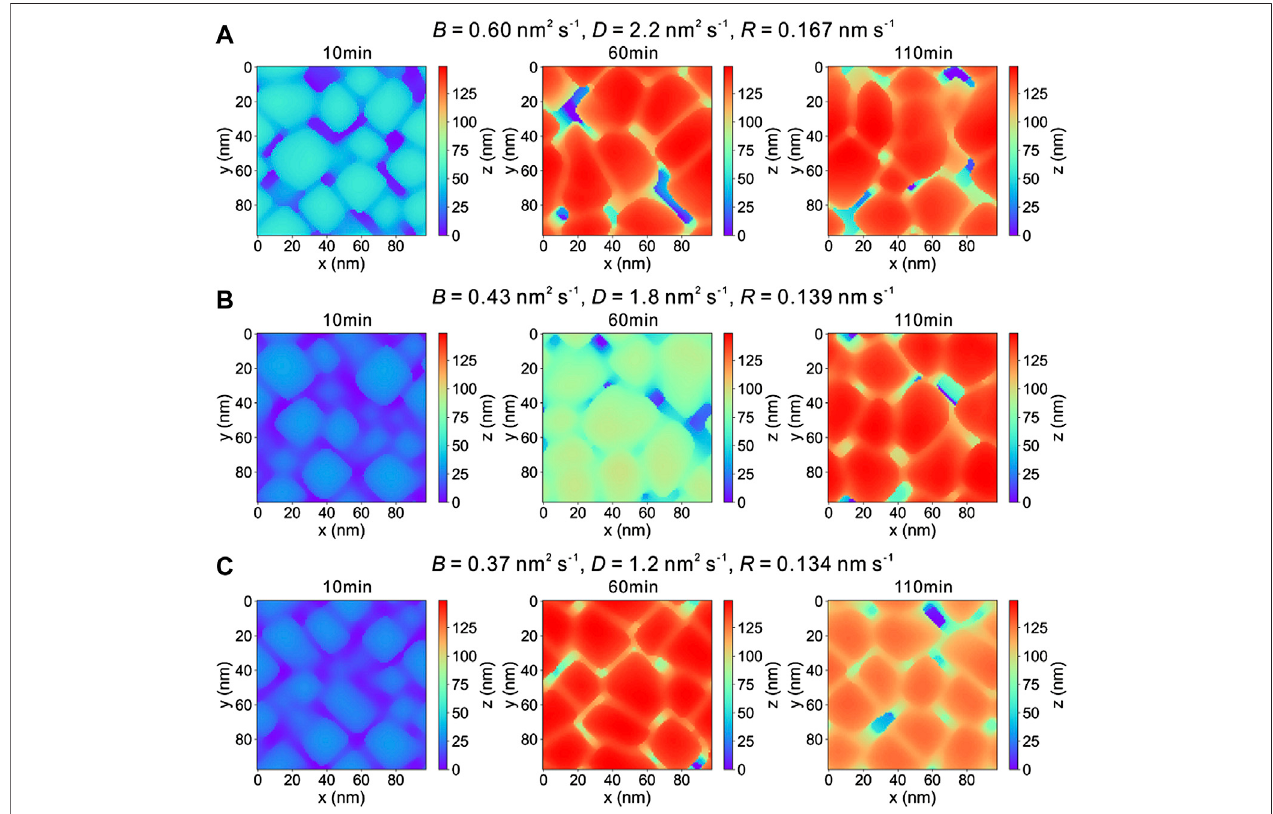
FIGURE2| Temporalsurface morphologiesofTiN coatingswithvarious deposition rates(i.e., R )correspondingtodifferentvapor – solidtransition velocities (i.e., B ) and diffusion coef fi cient (i.e., D ) during the 3D phase- fi eld simulation for PVD: (A) B = 0.60 nm 2 s − 1 , D = 2.2 nm 2 s − 1 , R = 0.167 nm s − 1 . (B) B = 0.43 nm 2 s − 1 , D =